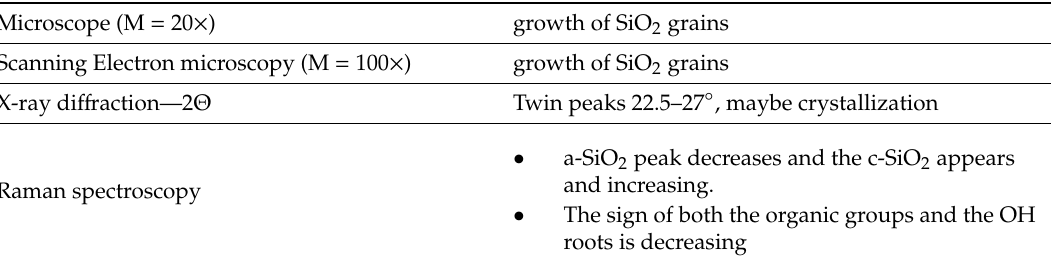
Table 3. The material test